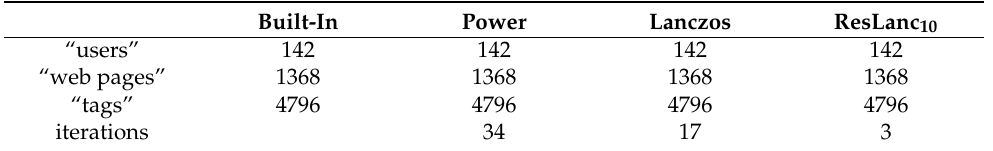
number of iterations required by each method.